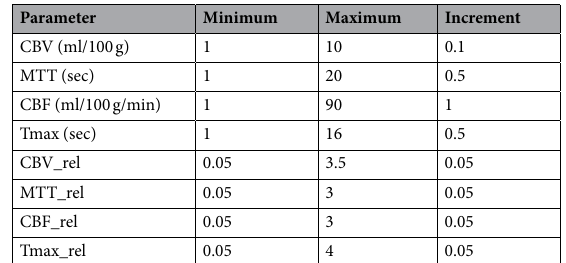
Table 2. Thresholds used for evaluation of ATI with minimum and maximum values as well as applied increment. CBV = cerebral blood volume. MTT = mean transit time. CBF = cerebral blood flow. Tmax = time to the maximum of the residue function obtained by deconvolution.